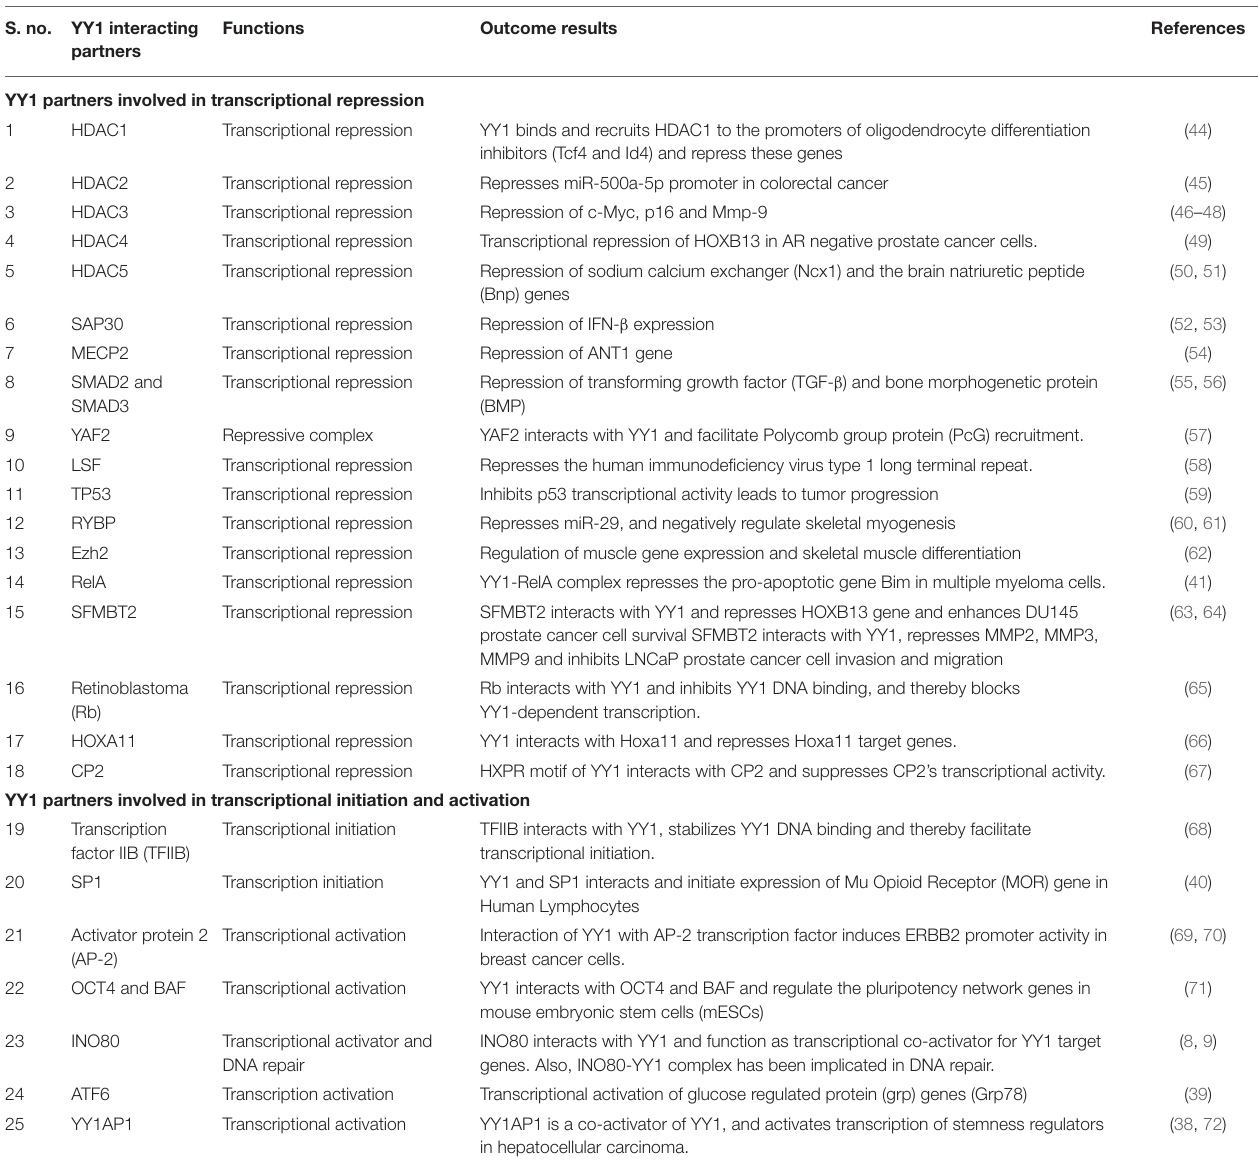
TABLE 1 | YY1 protein-protein interacting partners and their role in transcriptional